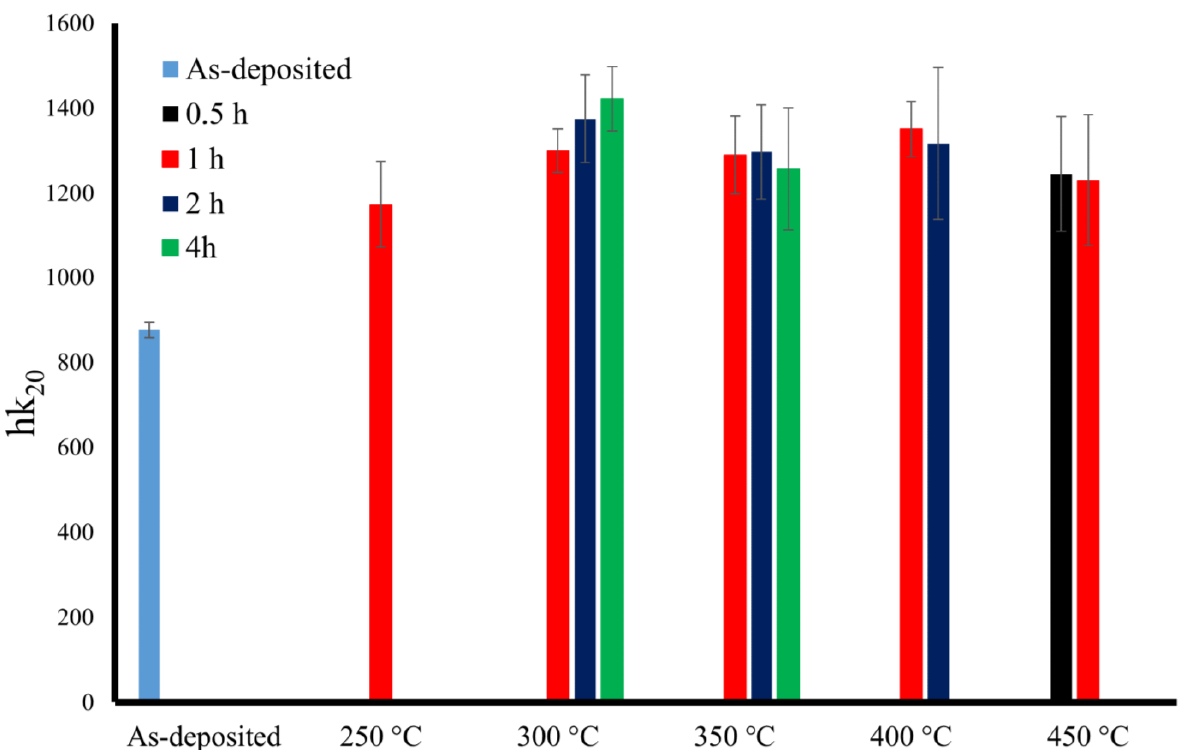
Figure 3. Cross-section hardness of the ENB coating in the as-deposited condition and after heat treatment at 250 °C, 300 °C, 350 °C, 400 °C, and 450 °C for 1 h, 2 h, 4 h, and 0.5 h. treatment at 250 ◦ C, 300 ◦ C, 350 ◦ C, 400 ◦ C, and 450 ◦ C for 1 h, 2 h, 4 h, and 0.5 h.